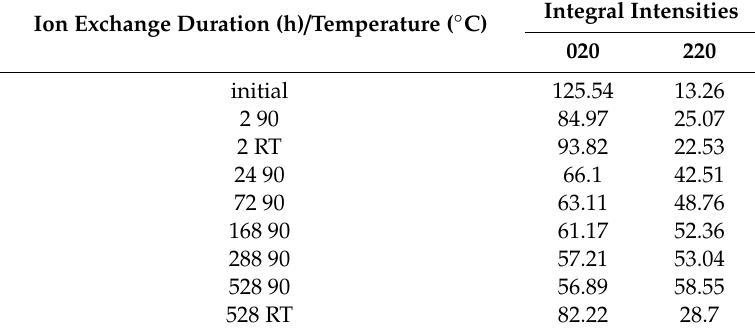
Figure 1. Powder XRD patterns of the purified clinoptilolite (bottom) and the Ba-exchange sequence of clinoptilolite at 90 °C ( left ) and room temperature (RT) ( right ) (from second pattern to top—2 h, 24 h, 72 h, 168 h, 12 days, and 22 days, of exchange). Table 1. Integral Intensities of 020 and 220 peaks of Ba-clinoptilolite for different exchange times and temperatures.